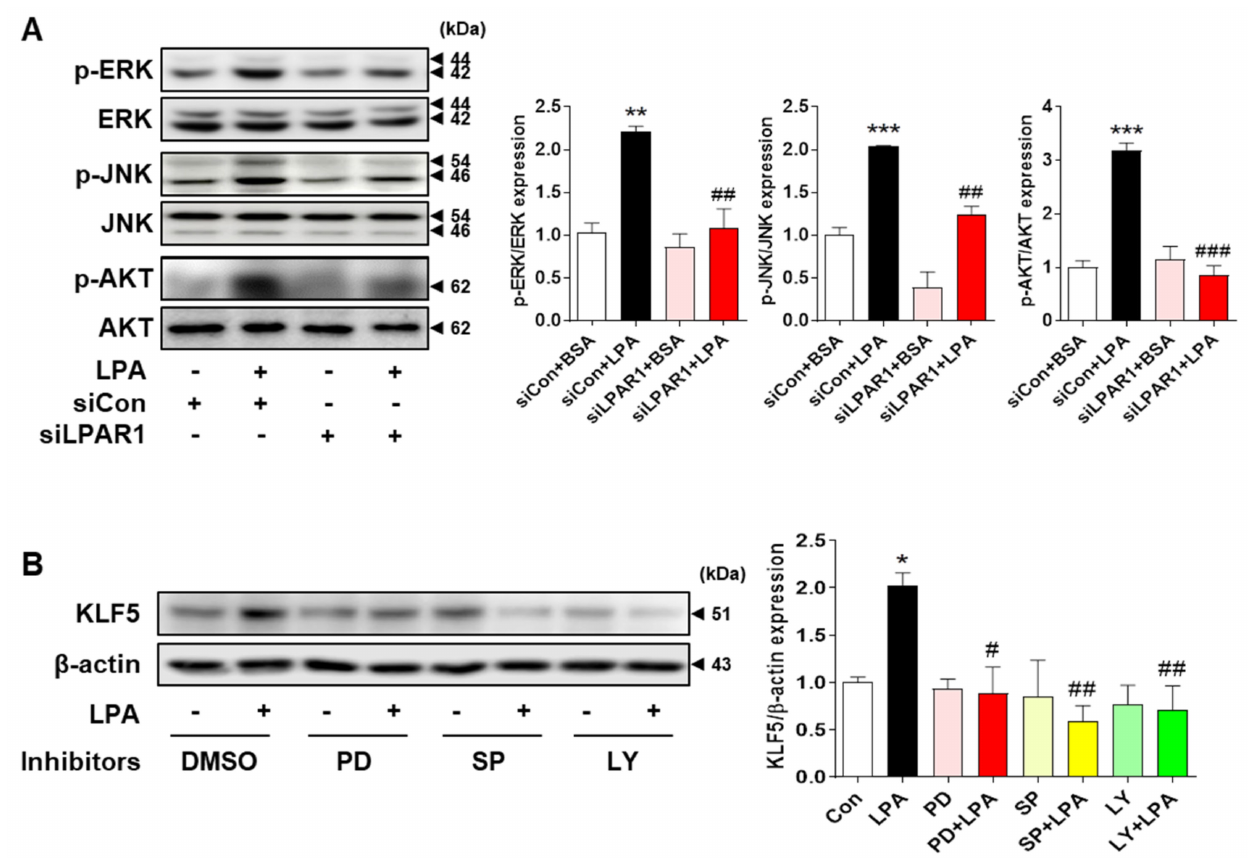
Figure 6. LPA − induced KLF5 expression is regulated by the MAPK and AKT signaling pathways in HK-2 cells. ( A ) HK-2 cells were transfected with a control siRNA (siCon) or LPAR1 siRNA (siLPAR1) and treated with or without 20 µ M LPA for 30 min. ( B ) HK-2 cells were pretreated with the vehicle (dimethyl sulfoxide (DMSO)), PD 98059 (PD; an extracellular signal-regulated kinase (ERK) inhibitor; 10 µ M), SP600125 (SP; a c-Jun N-terminal kinase (JNK) inhibitor; 10 µ M), or LY 294002 (LY; a phosphoinositide 3-kinase (PI3K)/serine-threonine kinase (AKT) inhibitor; 2.5 µ M) for 1 h, and subsequently treated with or without 20 µ M LPA for 30 min. Protein levels of ( A ) p-ERK, p-JNK, and p-AKT, and ( B ) KLF5 were analyzed via Western blotting, quantified using ImageJ software, and normalized to those of total ERK, total JNK, total AKT, and β -actin, respectively. Representative images (left) and quantitative analysis bar graphs (right) are shown ( n = 3 independent experiments). Data are presented as the mean ± SEM. * p < 0.05, ** p < 0.01, *** p < 0.005 vs. siCon + BSA or Con; # p < 0.05, ## p < 0.01, ### p < 0.005 vs. siCon + LPA or